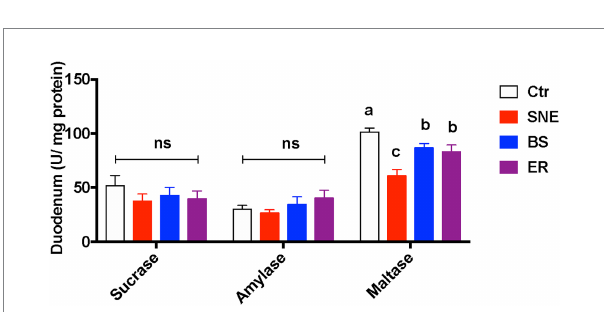
FIGURE 5 Duodenal mucosa biochemistry parameters of broiler chickens. Values are means (n = 10), with standard error of mean represented by vertical bars. (a, b, c) Mean values with unlike letters between different groups are significantly different ( p < 0·05). SEM, standard error of mean. Each value represents the mean ± SEM of 12 replicates ( n = 12). The abbreviation of Ctr, SNE, BS and ER have the same meaning as Table